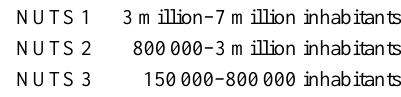
Table 3. NUTS level